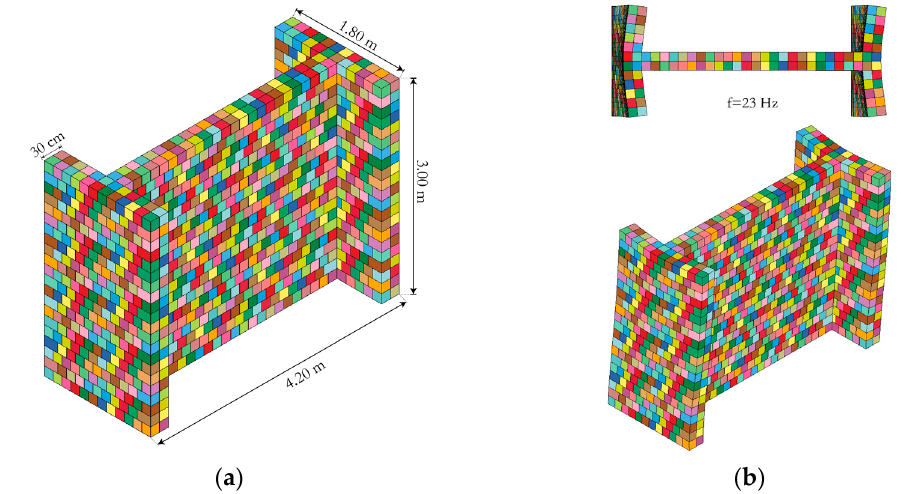
Figure 6. Recreated single adobe double-T wall in the LS-DYNA environment ( a ) dimensions and detailing; ( b ) Top and isometric view of the in-plane mode of vibration with its corresponding matched frequency f = 23 Hz.